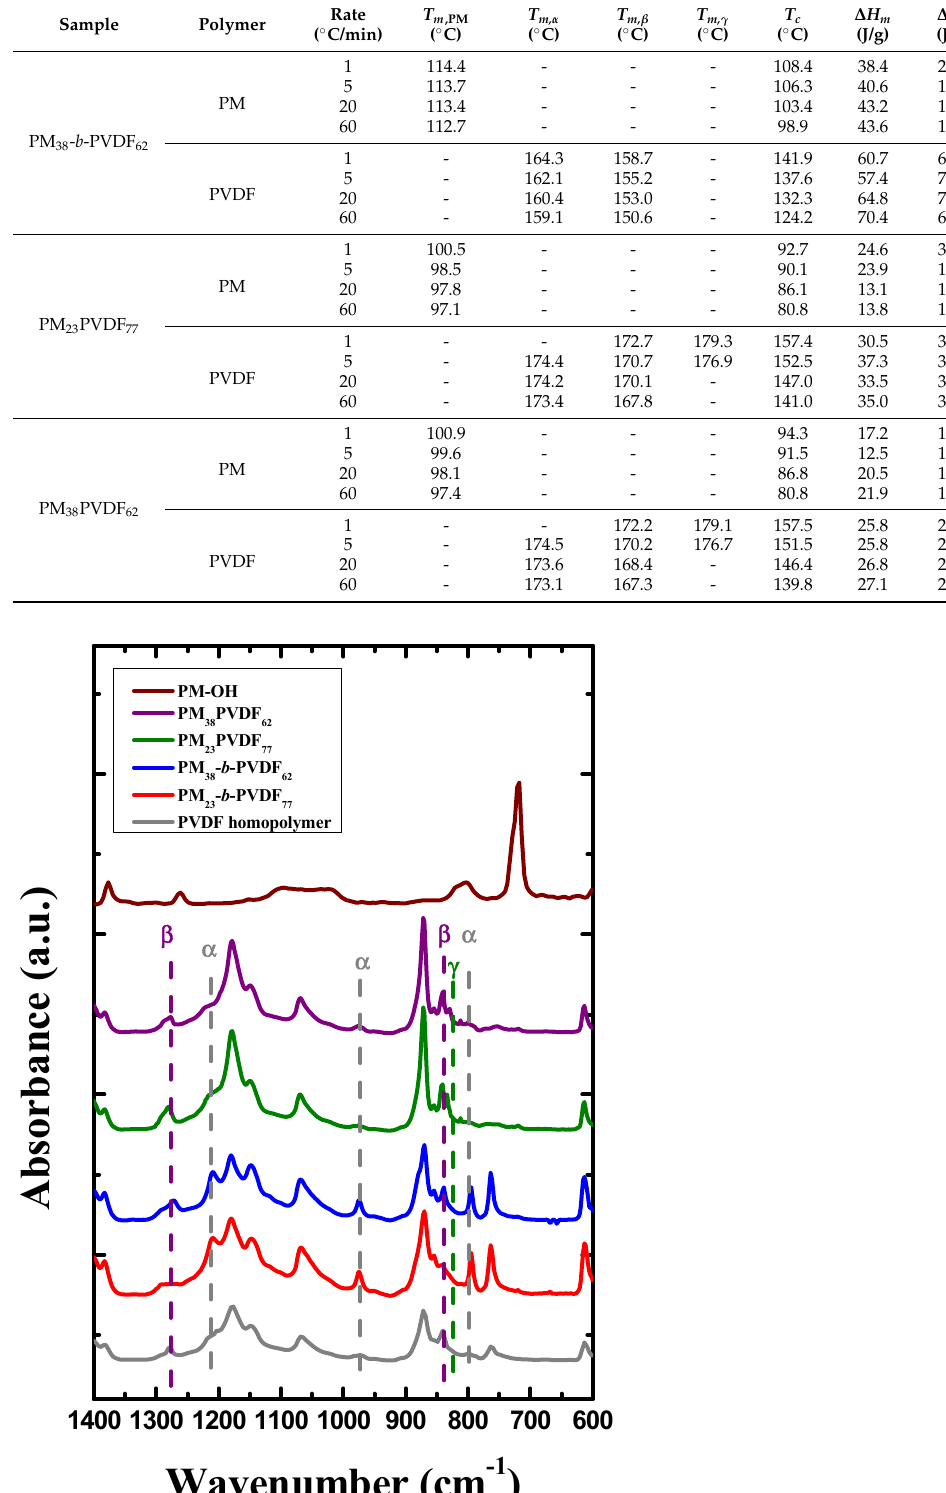
Figure 6. Sections of FTIR spectra of PM-OH, PVDF homopolymer, PM 23 - b -PVDF 77 , PM 38 - b -PVDF 62 , PM 23 PVDF 77 , and PM 38 PVDF 62 samples after a cooling sweep at 1 °C/min. The grey dashed line shows the bands for the α -phase; the purple dashed line is for the β -phase, and the green dashed line corresponds to the γ -phase.